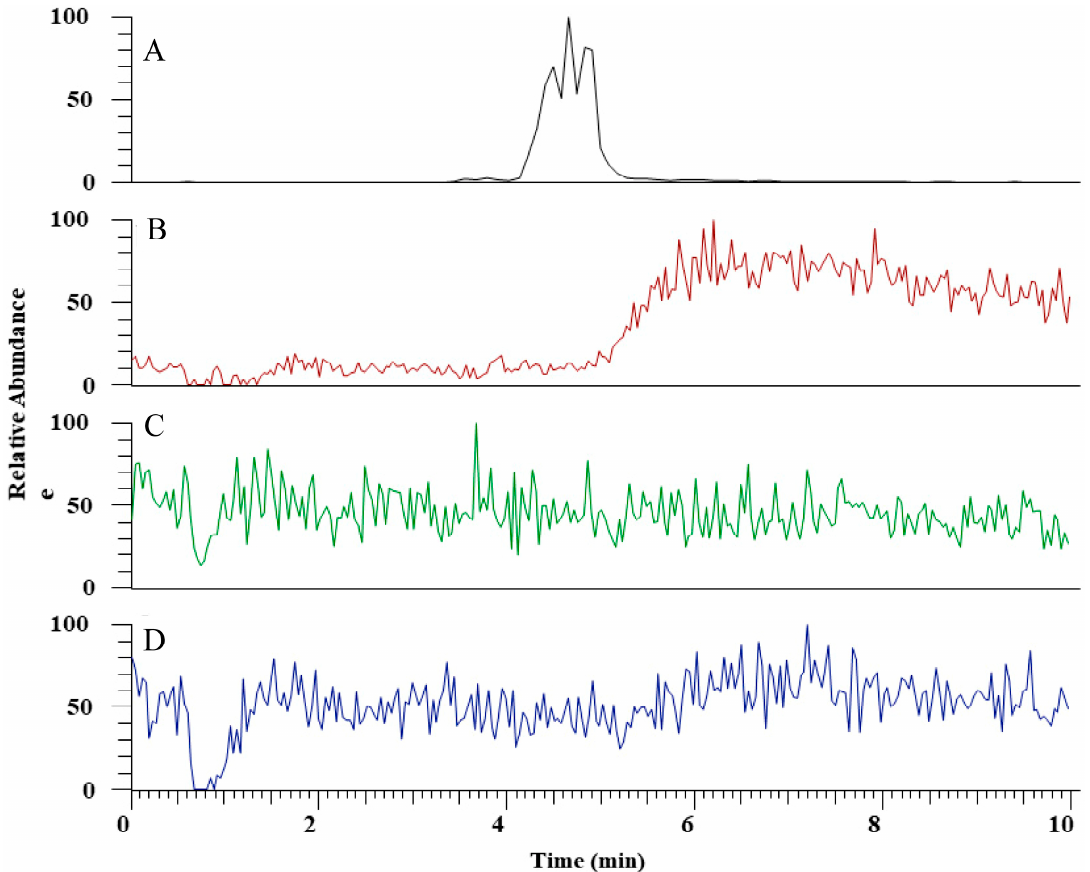
Figure 4. HPLC chromatogram for ( A ) mycolic acid standard, ( B ) mycolylarabinogalactan– peptidoglycan (mAGP) treated with LysB-D29, ( C ) mAGP treated with Rhizopus oryzae lipase, and ( D ) mAGP treated with buffer as negative control. The experimental details are described in Section 4.6.2.